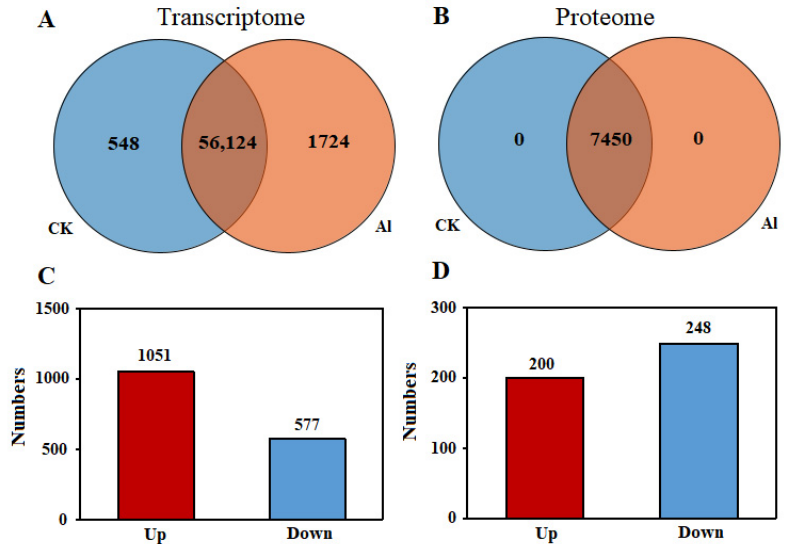
Figure 2. A statistical representation of the quantified transcripts and proteins. Venn diagrams for the quantified transcripts ( A ) and proteins ( B ) under Al 3+ treatment (red) or CK (blue). The amounts of differentially expressed genes ( C ) and proteins ( D ).